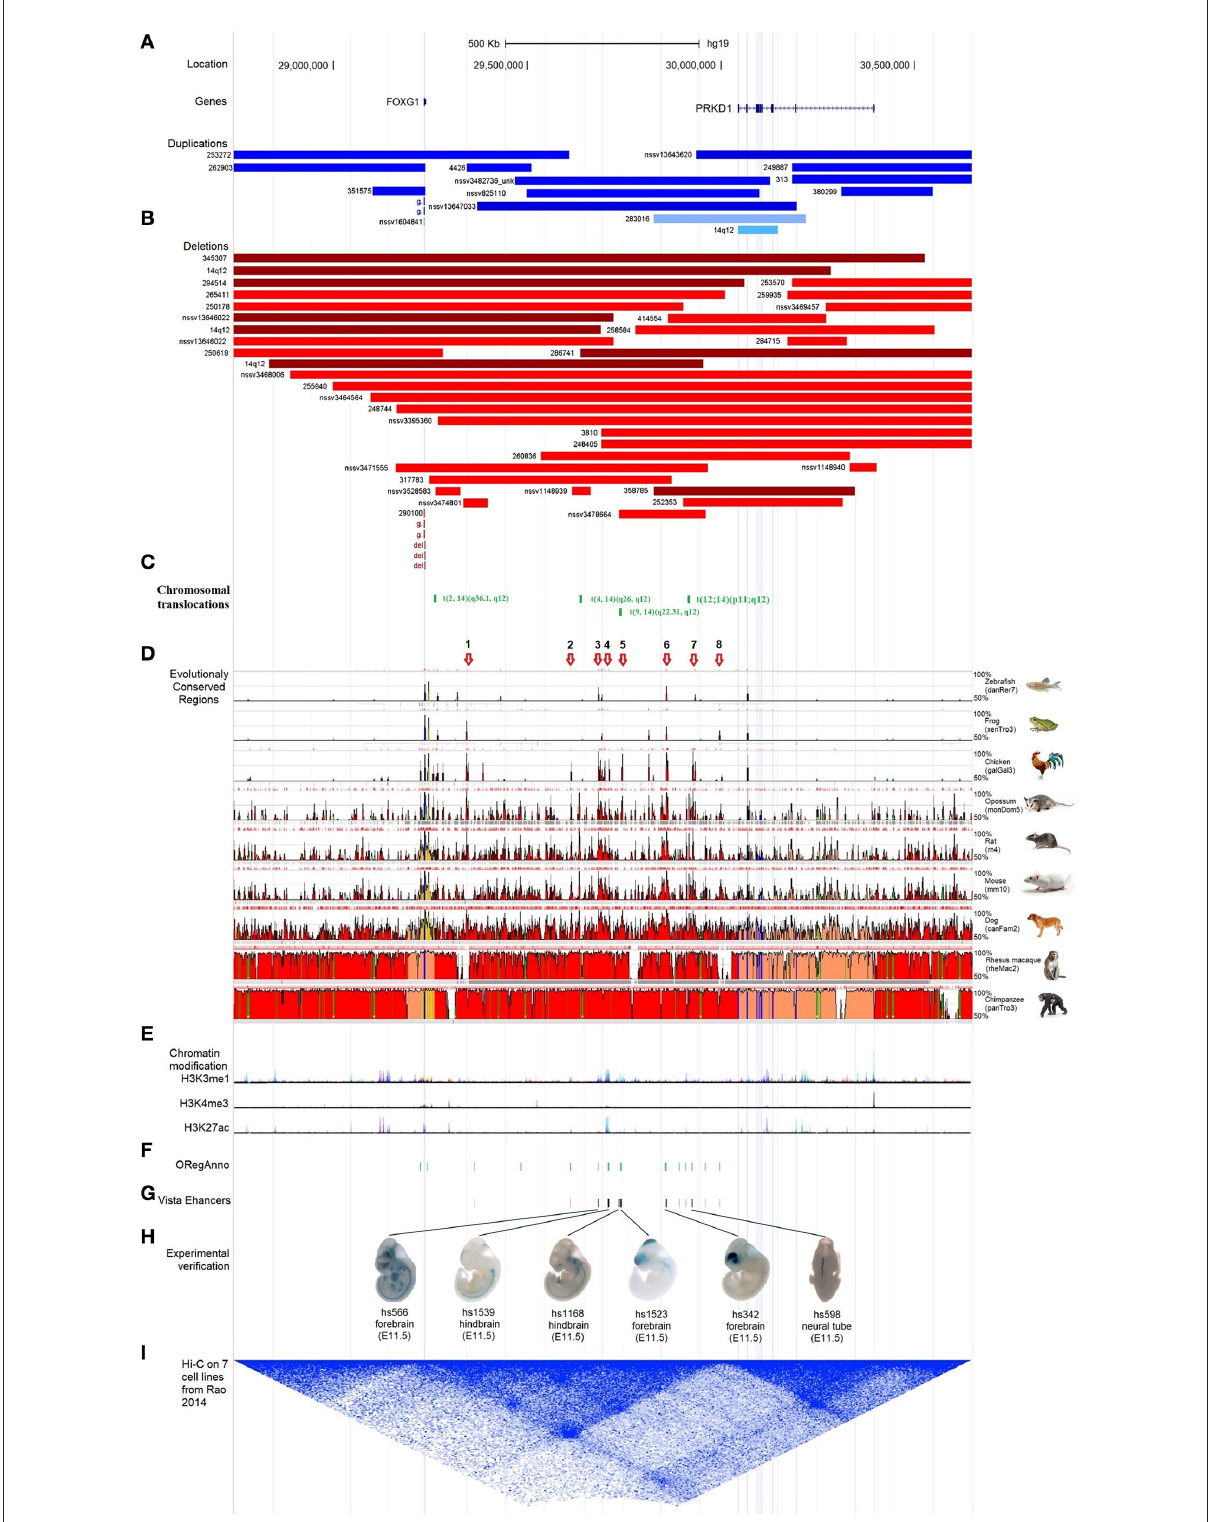
FIGURE6 Characterization of the regulatory elements in the intergenic region between FOXG1 and PRKD1. (A) Partially-covered microduplications; (B) Partially-covered microdeletions; (C) Chromosomal translocations; (D) Evolutional conservation analysis by ECR browser; (E) Chromatin modification of 7 human cells from ENCODE; (F) Regulatory elements in ORegAnno database; (G) Enhancers in VISTA enhancer browser; (H) 6 neuronal active enhancers in mouse embryos; (I) In situ Hi-C for seven human cell